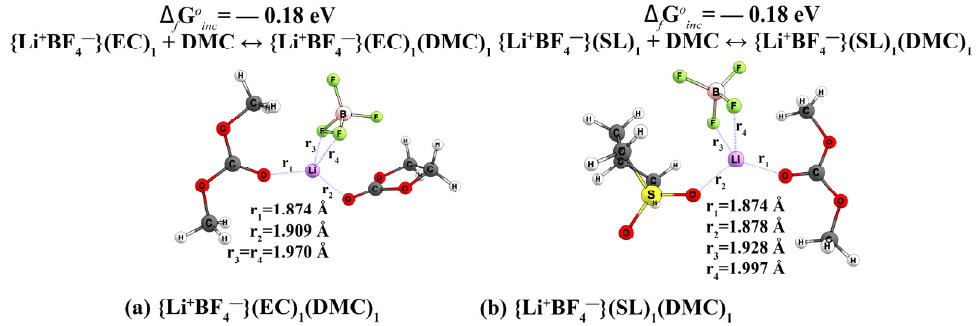
Figure 6. Geometric structure of mixed-type complexes {Li + BF 4 − } for system (EC) 1 (DMC) 1 ( a ) and system (SL) 1 (DMC) 1 ( b ).